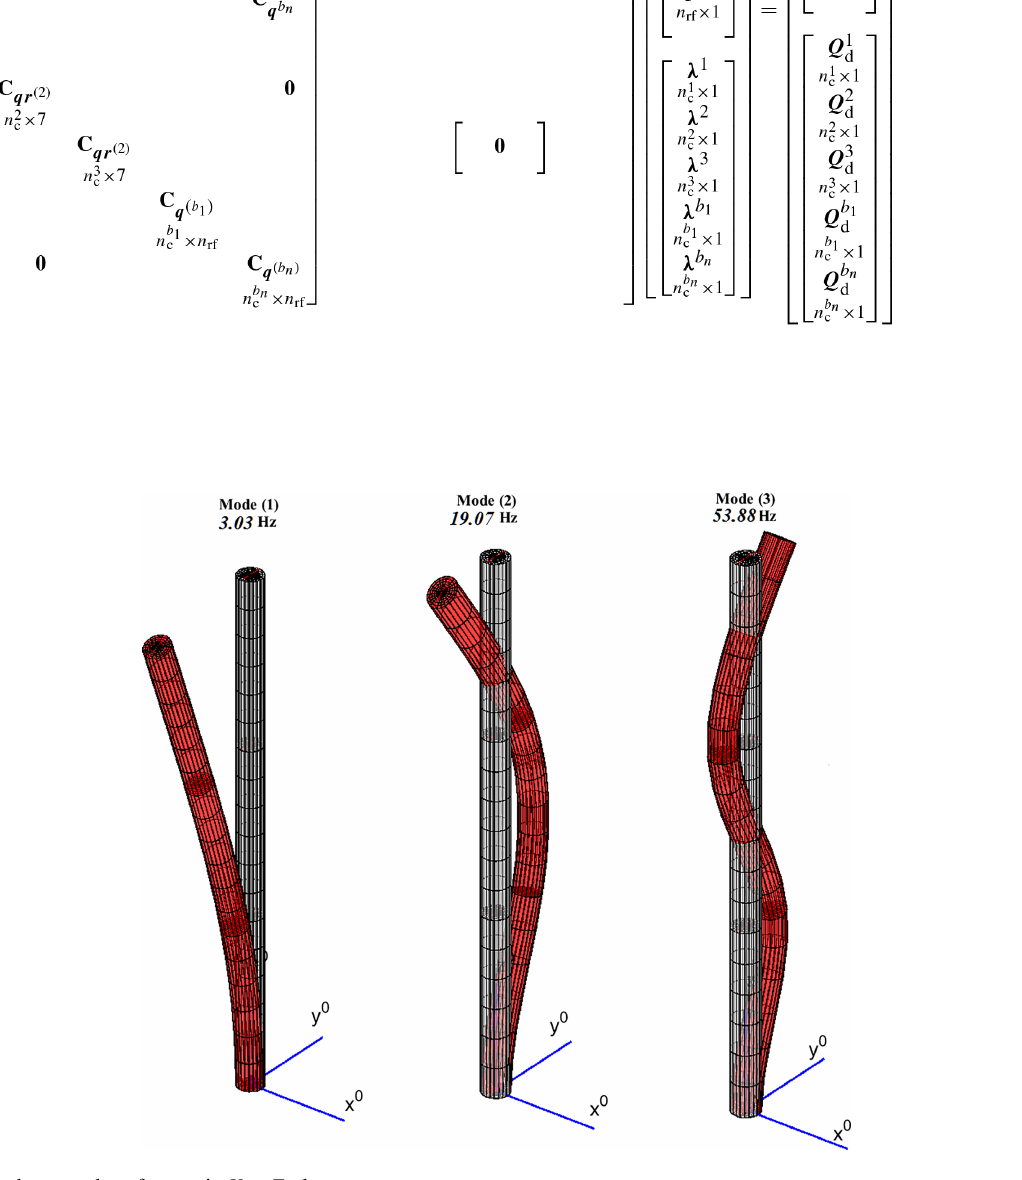
Figure 5. First three modes of tower in Y − Z